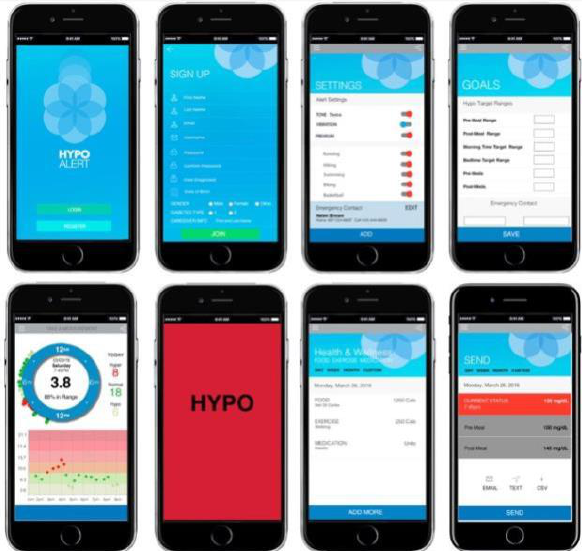
Figure 3. Illustrates the second iteration HYPOalert interactive prototype that focus on data monitoring using several temporal systems, the alert system, along with reminders, settings, and summary